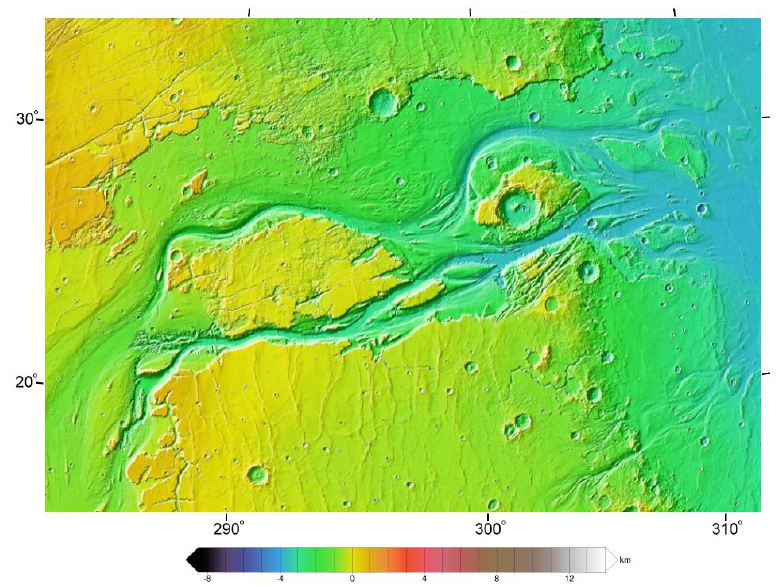
Figure 2. Kasei Valles — a major outflow channel — seen in Mars orbiter laser altimeter (MOLA) elevation data. The flow was from the bottom left to right. The image is approx. 1600 km across. The channel system extends another 1200 km south of this image to Echus Chasma.